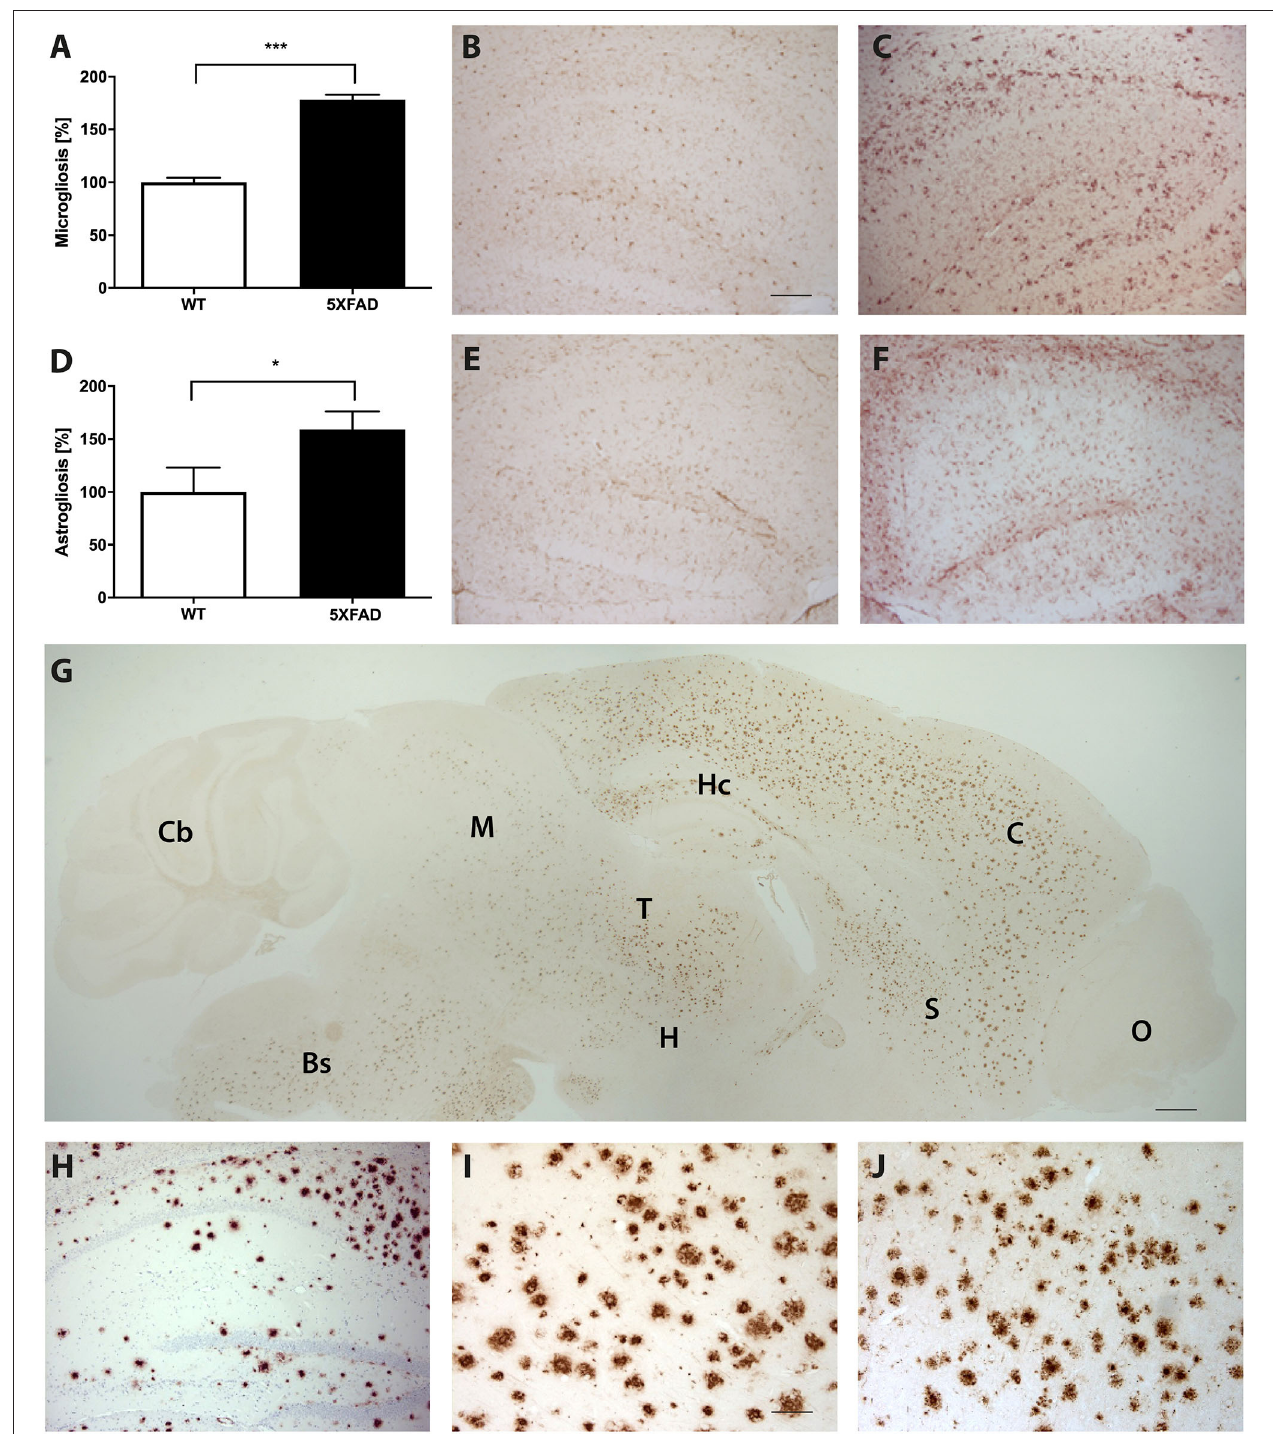
FIGURE 5 | Increased astrogliosis, microgliosis, and A β -expression in 5XFAD mice. (A) Significantly more reactive microglia activity in the brain of 7-month-old 5XFAD mice compared to age-matched WT controls. Examples of hippocampal sections of (B) WT and (C) 5XFAD mice. (D) 5XFAD mice displayed significantly more astroglia reactivity than WT controls. Examples of hippocampal sections of (E) WT and (F) 5XFAD. (G) A β -expression in 5XFAD mice shows plaque pathology in various brain regions except of olfactory bulb and cerebellum. Bs, Brain Stem; C, Cortex; Cb, Cerebellum, H, Hypothalamus; Hc, Hippocampus; M, Midbrain; O, Olfactory Bulb; S, Septum/Basal Forebrain; T, Thalamus. (H–J) Examples of plaque pathology in the (G) hippocampus, (H) cortex, and (I) thalamus of 5XFAD mice. Scale bars in (B) for (C,E,F,H) = 200 µ m; Scale bar in G = 500 µ m; Scale bar in (I) for J = 50 µ m. Unpaired t -test; *** p < 0.0001; * p < 0.05; data presented as mean ± SEM.